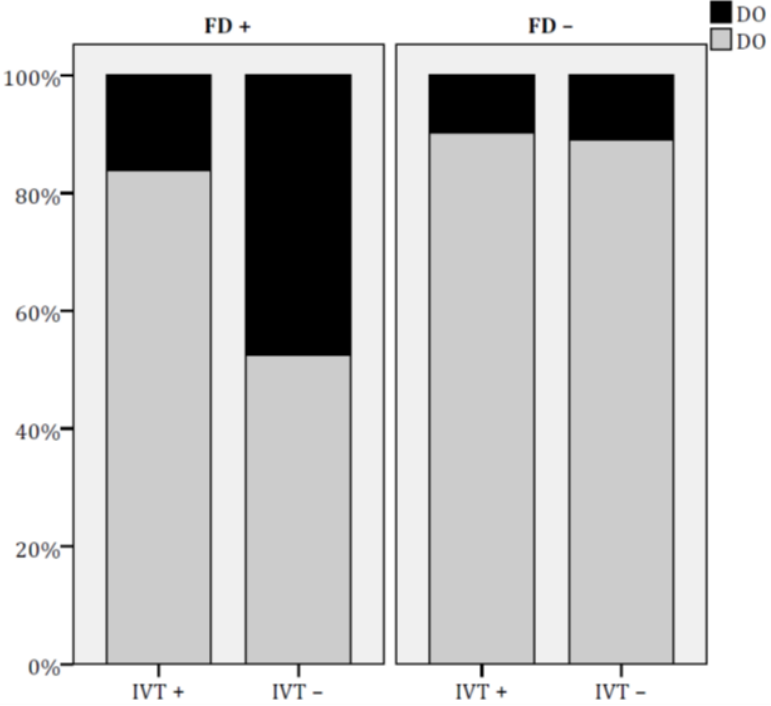
Figure 2. Effect of IVT on disability outcome rates in groups of patients with different levels of functional dependence at admission. DO = disability outcome; FD = functional dependence; IVT = intravenous thrombolysis.